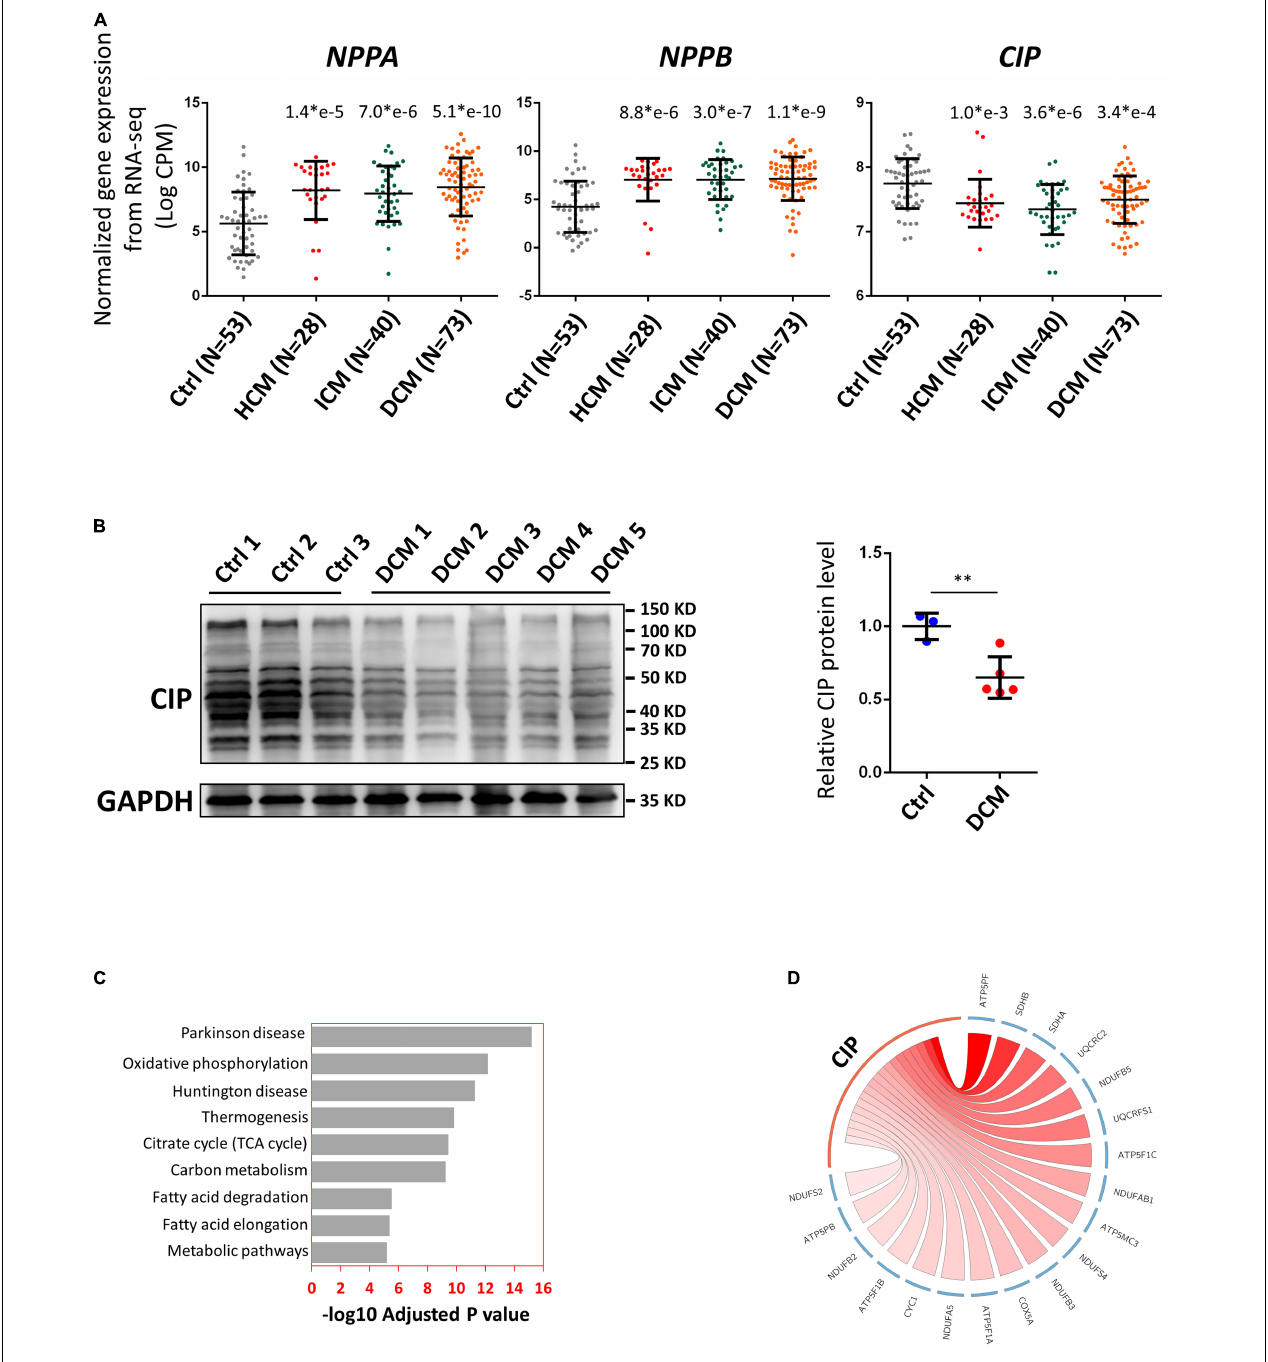
FIGURE 2 | Cardiac ISL1-interacting protein expression is down-regulated in diseased human hearts. (A) Relative gene expression indicated by log counts per million (CPM) from disease human heart RNA-seq data. N number for each group is show. The significance between each category of heart disease and control was tested with 1-way ANOVA with post hoc Tukey’s test and shown. (B) Western blotting detecting the expression of CIP in human hearts with dilated cardiomyopathy (DCM) and controls. GAPDH served as loading control. The significance between groups was tested with 1-way ANOVA with post hoc Tukey’s test. ∗∗ P < 0.01. (C) The ranking of enriched KEGG pathways in the gene set having strong expression correlation coefficient with CIP, which is determined by Spearman correlation coefficient (SCC). SCC between CIP and individual genes genome-wide from 194 human hearts was calculated. Pathways were ranked by the adjusted P value. (D) The expression of CIP has strong expression correlation coefficient with oxidative phosphorylation (OXPHOS) related genes in human heart ( p = 6.77 × e10 - 13 ). OXPHOS genes with SCC > 0.4 are shown in Circos plot. The color of line linked between CIP and each gene indicates the expression correlation coefficient. A darker line suggests a stronger expression correlation